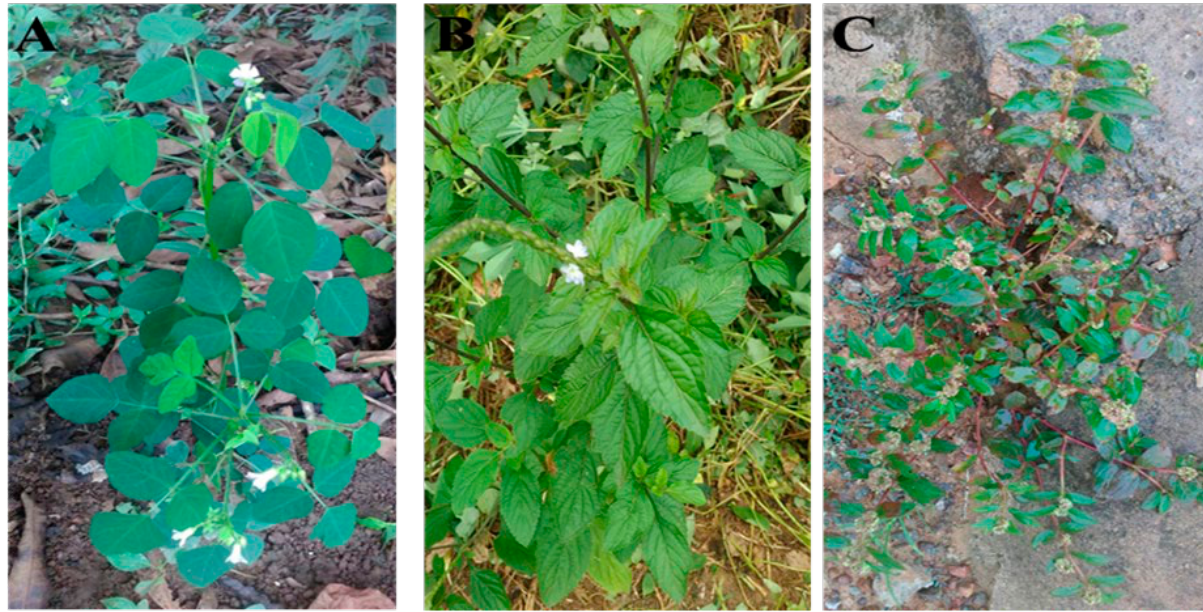
Figure 1. Pan-tropical plants examined in the present study: Oxalis barrelieri L. (A), Stachytarpheta cayennensis L. (B), and Euphorbia hirta L. (C). These plants are shown at the beginning of the flowering stage, during which they were harvested and